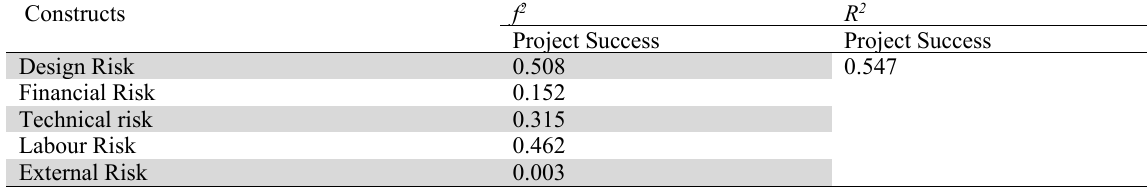
Values of coefficient of determination (R2) and effect size (f2)